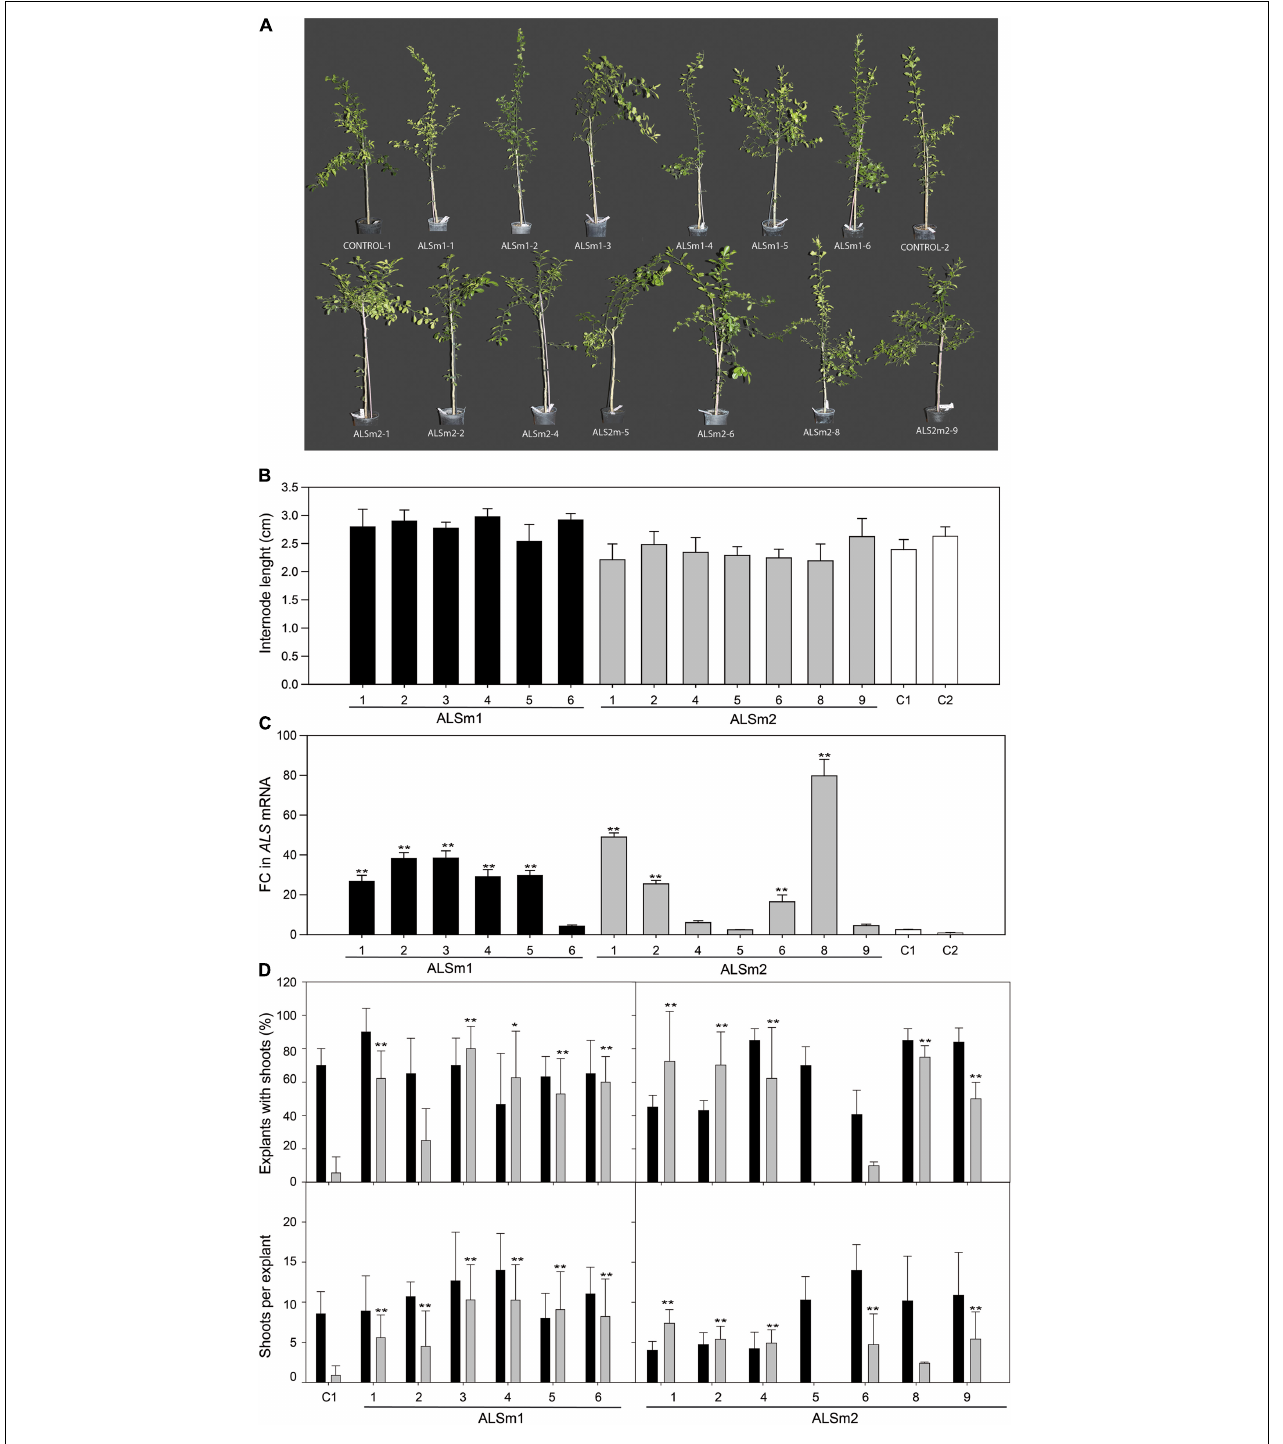
FIGURE 2 | (A) Representative pictures of whole plants and (B) evaluation of internode length of shoots from ALSm1, ALSm2, and control non-transformed Carrizo citrange lines after 12 months of growth and cultivation in the greenhouse. (C) Fold-change (FC) in ALS expression between engineered (ALSm1, ALSm2) and non-transformed lines. (D) Shooting ability, represented as explants with shoots (top) and shoots per explant (down) of control, ALSm1, and ALSm2 explants in culture medium without selective pressure (black bars) or supplemented with 0.5 imazapyr (gray bars). Bars represent the mean values ± SD of at least three biological replicates. Significant differences in relation to C1 (regenerated control) and ALSm5 (non-transgenic escape) after LSD tests are marked by asterisks (* p < 0.05; ** p < 0.01).